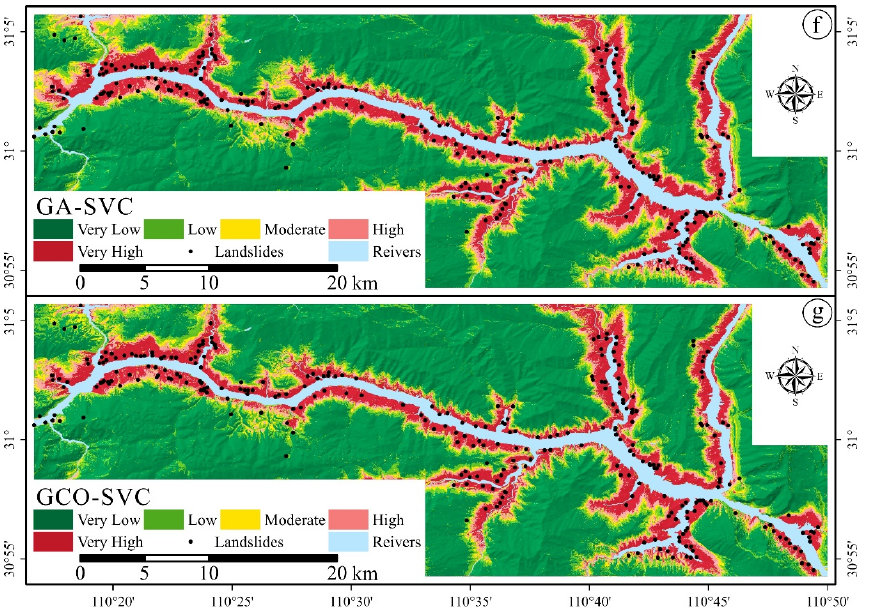
Figure 8. Landslide susceptibility maps of the seven models, includes ( a ) ANN, ( b ) DT, ( c ) KNN, ( d ) RF, ( e ) GRID ‐ SVC, ( f ) GA ‐ SVC, and ( g ) GCO ‐ SVC.